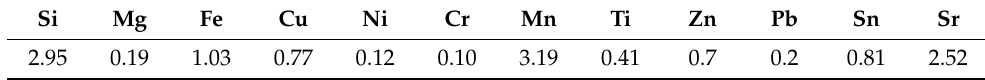
Table 2. Statistical Student “t” coefficients for FRP.